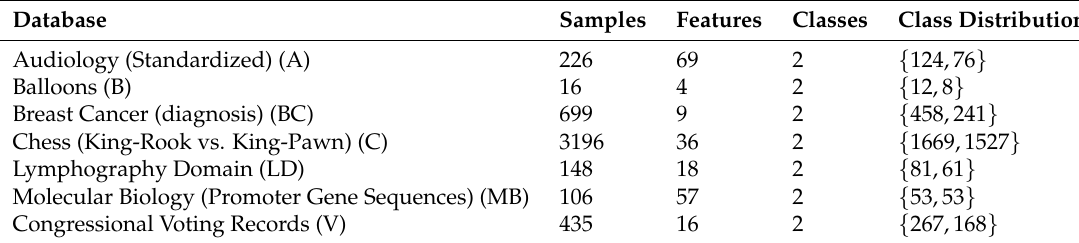
Table 1. Categorical datasets downloaded from public UCI repository.